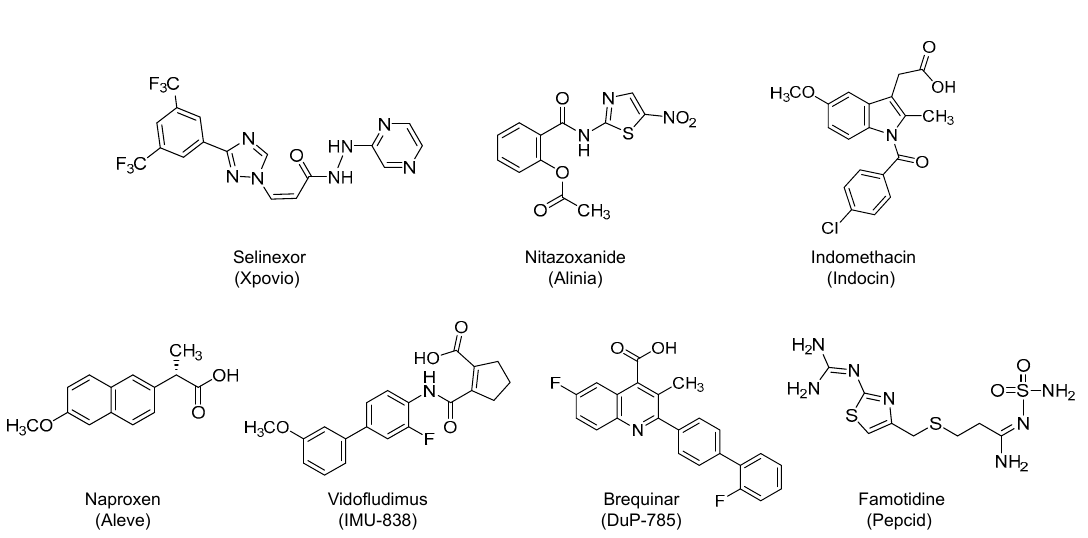
Figure 7. Chemical structures of miscellaneous potential antiviral agents. Of note, the antiviral activity of two NSAIDs (indomethacin and naproxen) and the antiviral activity of dihydroorotate dehydrogenase inhibitors (vidofludimus and brequinar). Many of these drugs also exhibit anti-inflammatory/immunomodulatory effects.